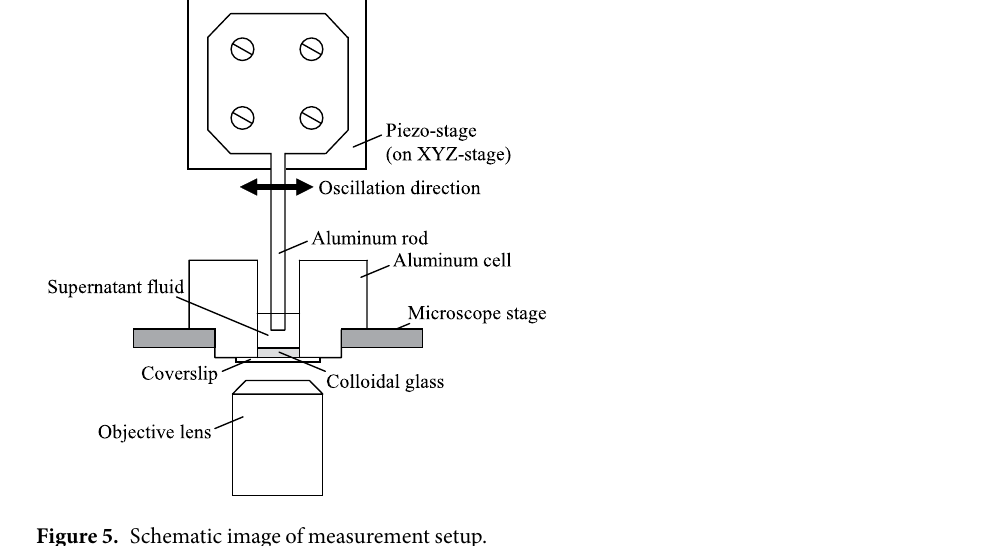
Figure 5. Schematic image of measurement